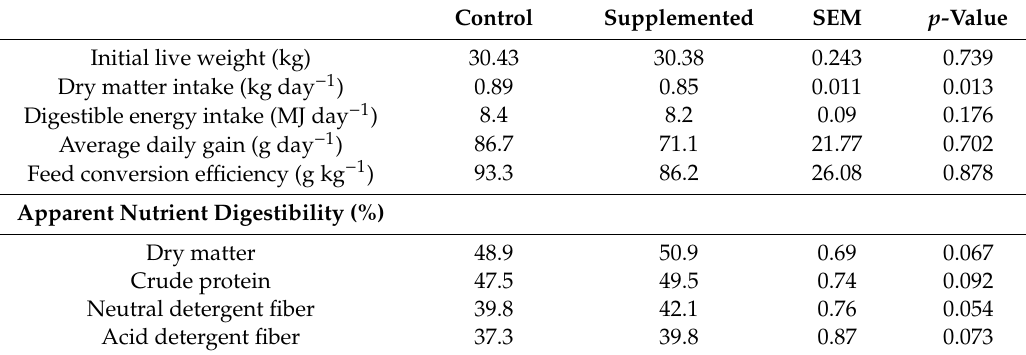
Table 3. Effects of a 4.5% licorice root extract supplementation on intake, average daily gain,